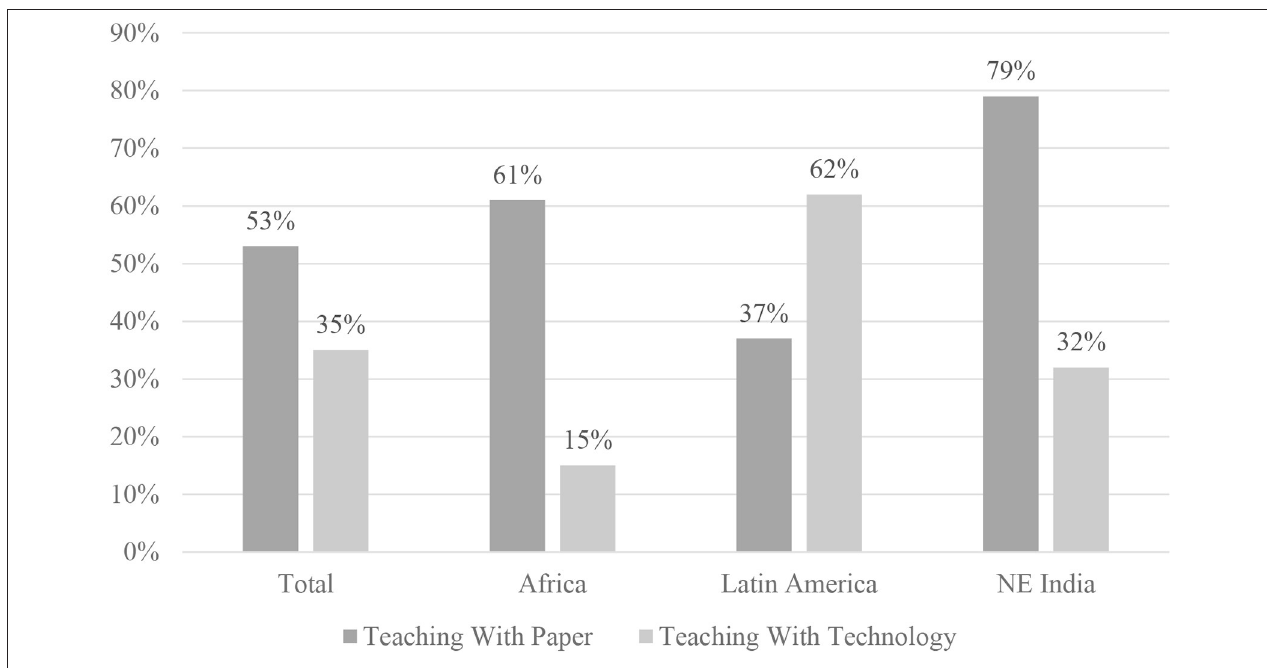
FIGURE 1 | Use of paper and technology (Edify Education Task Force, 2020).